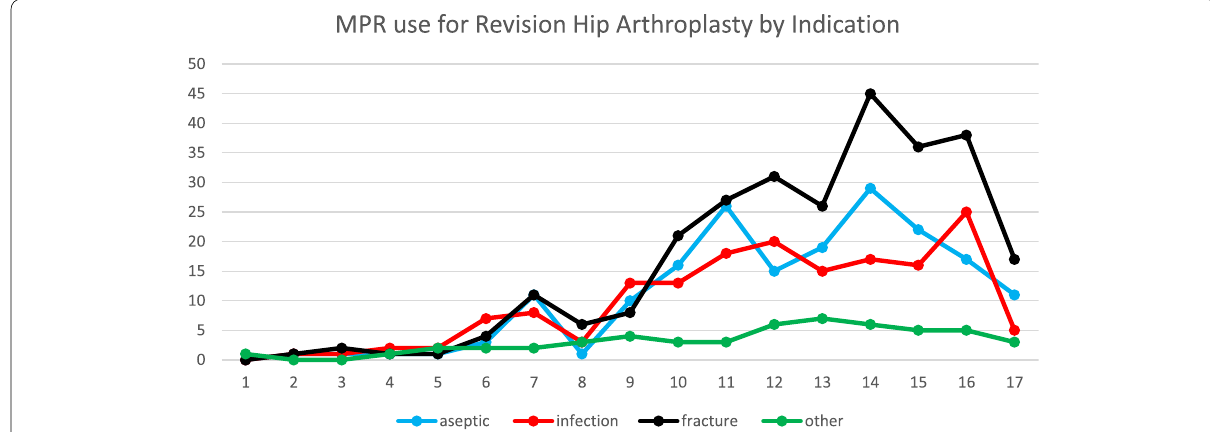
Fig. 3 Megaprosthesis use by indication in hip revision procedures